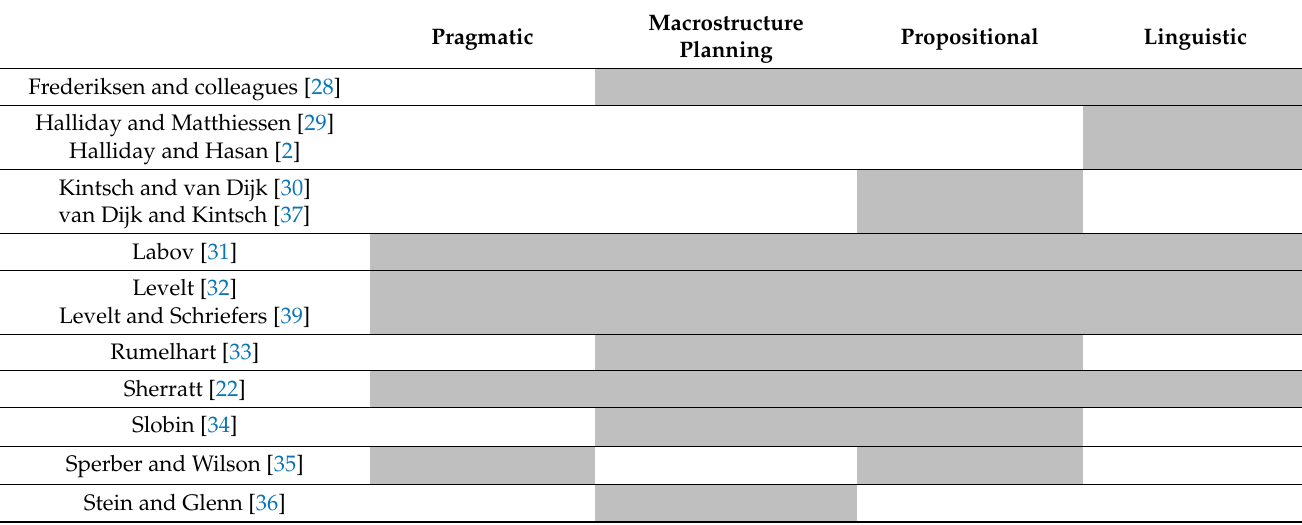
Table 2. Source material mapped against four categories of concept/construct in spoken discourse-the shaded cells indicate which sources contain information relating to each category. Macrostructure Pragmatic Propositional Planning